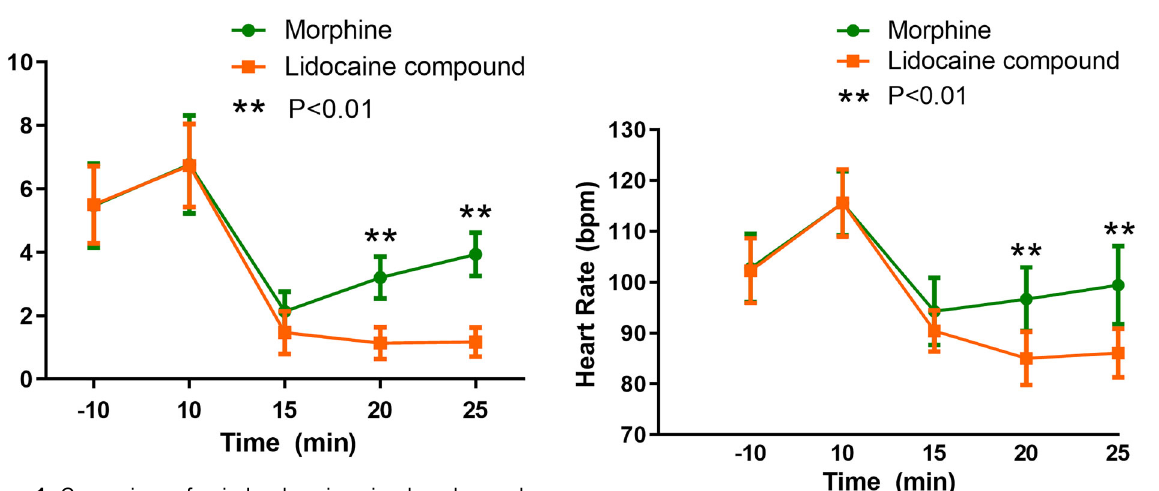
Figure 1. Comparison of pain levels using visual analog scale (VAS) scores between two groups of patients receiving systemic morphine or topical lidocaine for cancer wound dressing change. Data was collected 10 min before the treatment and 10, 15, 20, and 25 min after. Student ’ s t -test was used for statistical analysis (P o